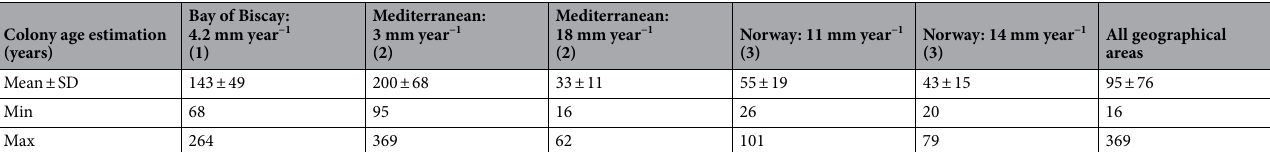
Table 5. Age estimations for the Angolan Madrepora colonies based on growth rates being available for the Bay of Biscay, Mediterranean Sea and Norway. For calculations, all Madrepora colonies measured on all mounds were considered (n = 30). Last column displays the mean age (± SD) as well as the minimum and maximum ages for all colonies measured considering all growth rates and geographical areas. (1)